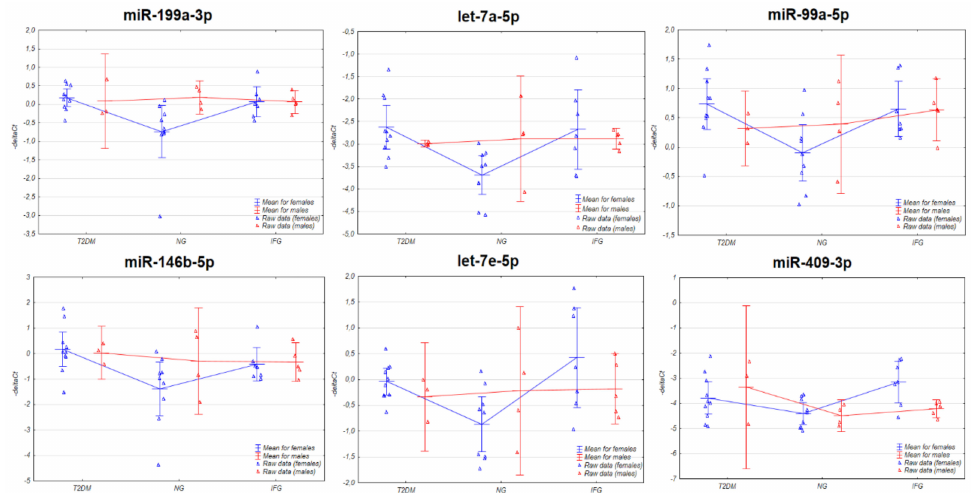
Figure A4. Plots for miR-127-3p, miR-125b-5p, let-7d-5p, miR-155-5p, miR-342-3p and miR-532-3p showing mean-deltaCt values with regard to studied group and sex for all study subjects (N = 38).